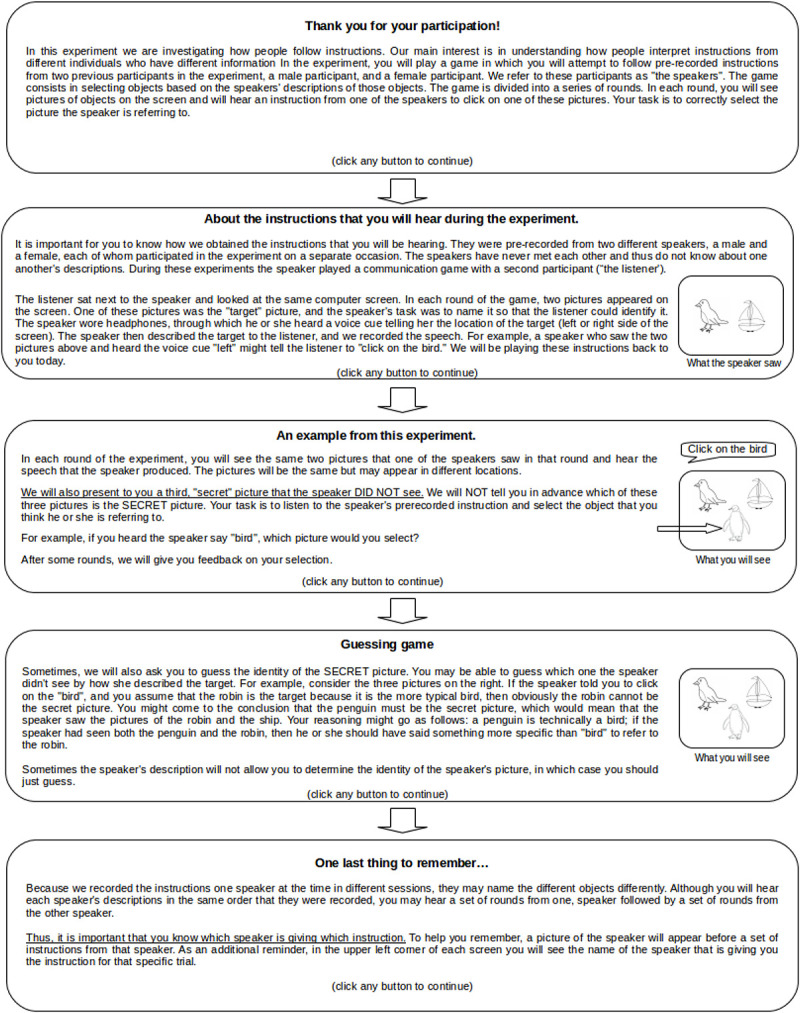
Schematic of the instructions given to participants before the experiment started.